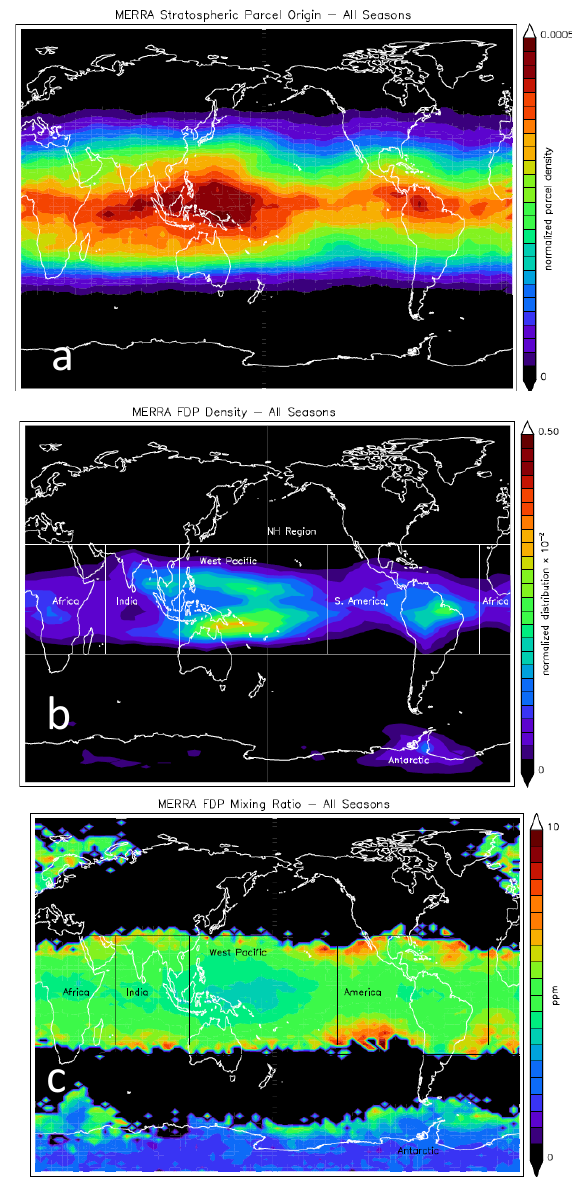
Fig. 6. Joint PDF of MERRA starting locations of parcels that as- cended into the stratosphere vs. final water vapor values. Top, lati- tude vs. water vapor; bottom, longitude vs. water vapor. The color scheme and color bars referenced as in Fig. 1. The color indicates the number of parcels in a bin showing where the concentration of parcels is